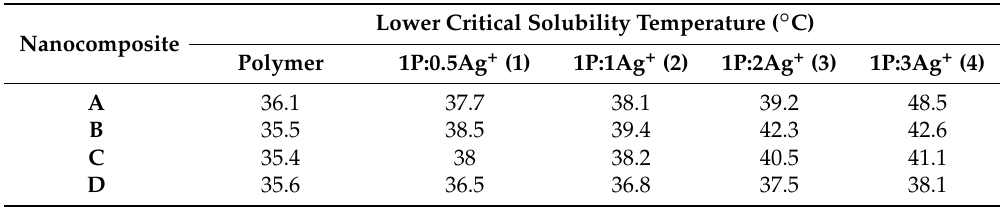
Figure 11. LCST behavior of the polymer A ( a ) and D ( b ) and the corresponding nanocomposites. Table 6. Lower critical solubility temperatures of the polymers and the final composites.